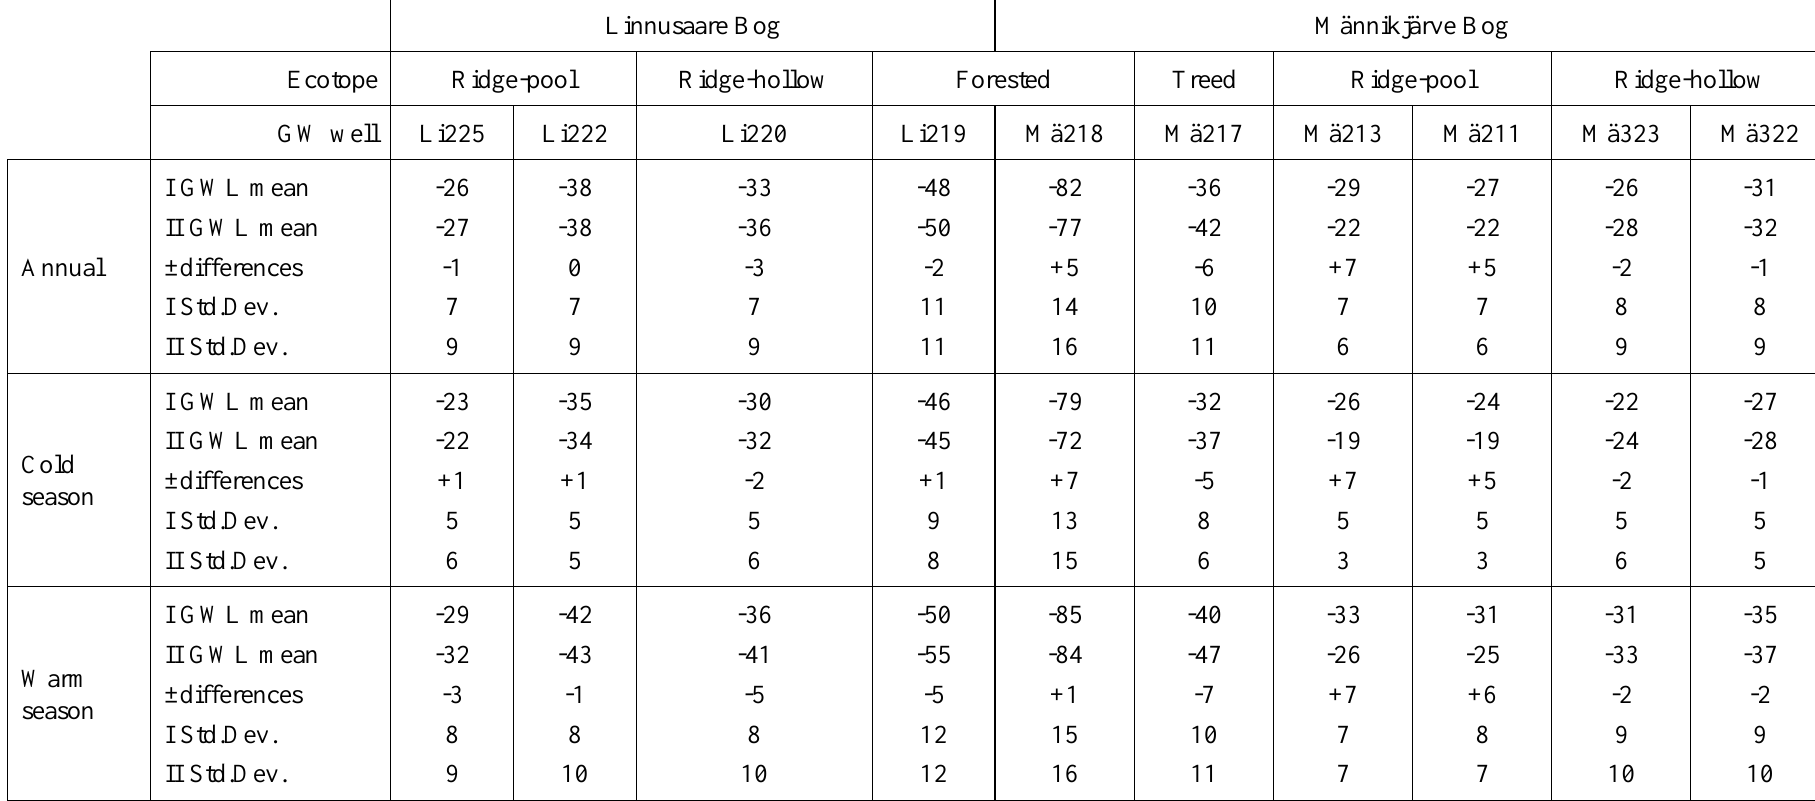
Table A2. Statistics for Period I and Period II monthly GWLs (cm) in different ecotopes of Linnusaare (Li) and Männikjärve (Mä)